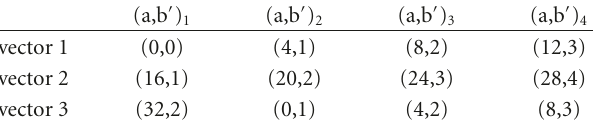
Table 6: Reading with